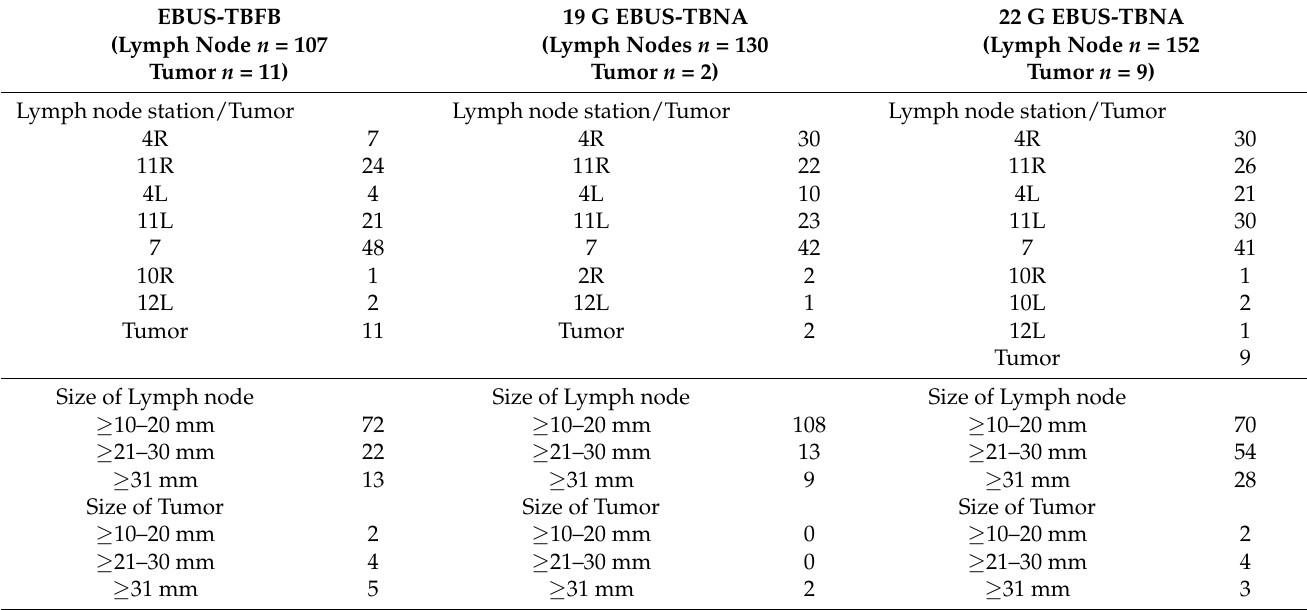
Abbreviations: EBUS = endobronchial ultrasound-guided, TBNA = transbronchial needle aspiration, TBFB = transbronchial forceps